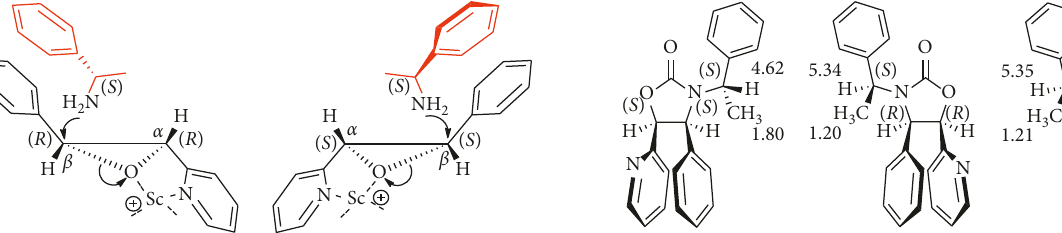
Figure 1: Models for regioselective aminolysis of rac-trans - 11 .